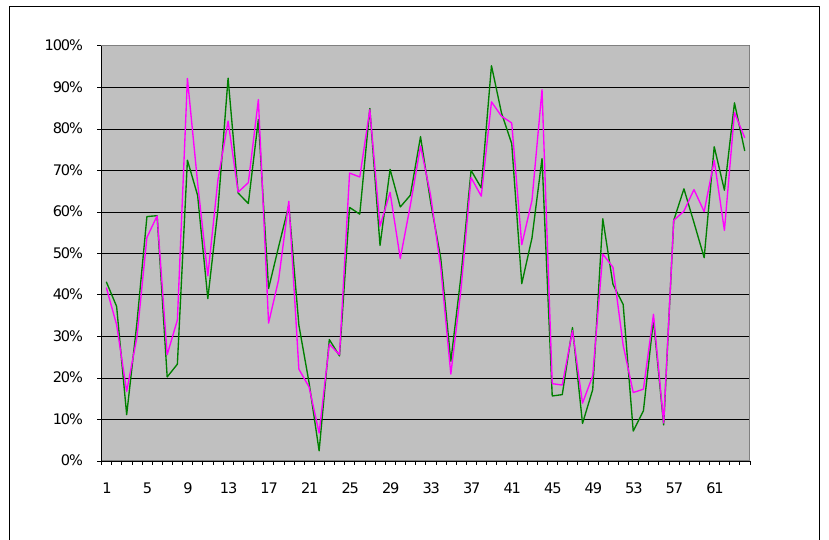
Figure 5. Plot of the percentages of coverage obtained from the template images (green) and from the computed images